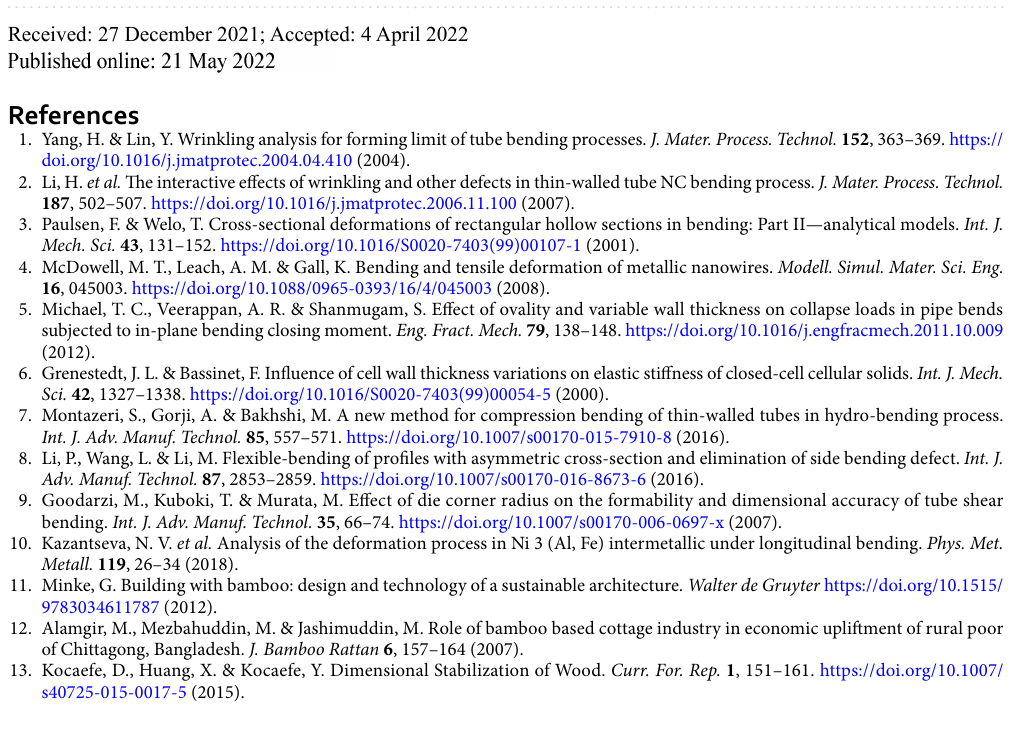
Figure 9. Correlation between ( a ) MOE and density, ( b ) MOE and MFA, and ( c ) MFA and density, of different bamboo cross-section